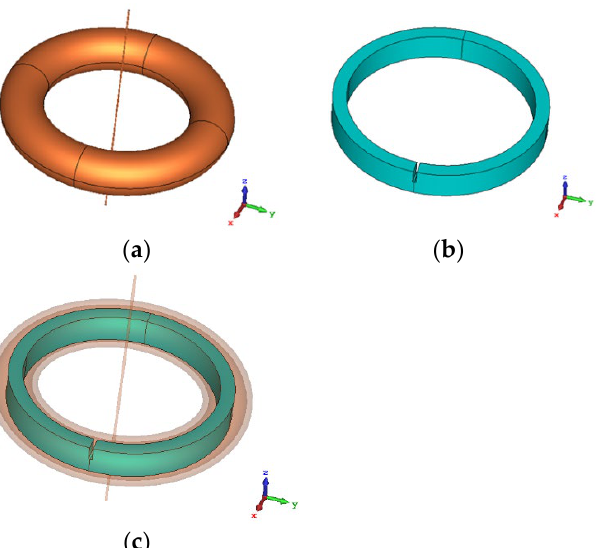
Figure 7. Numerical model of magnetic part. ( a ) Coil and straight wire; ( b ) Magnetic core with air gap; ( c ) Position relationship between coil and core.